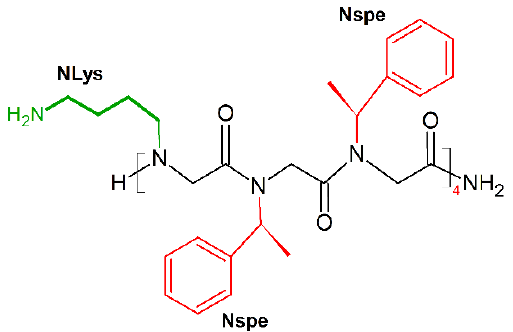
Figure 15. Chemical structure of (NLys-Nspe-Nspe) 4 peptoid. In green: positively charged side chain; in red: hydrophobic side chain.